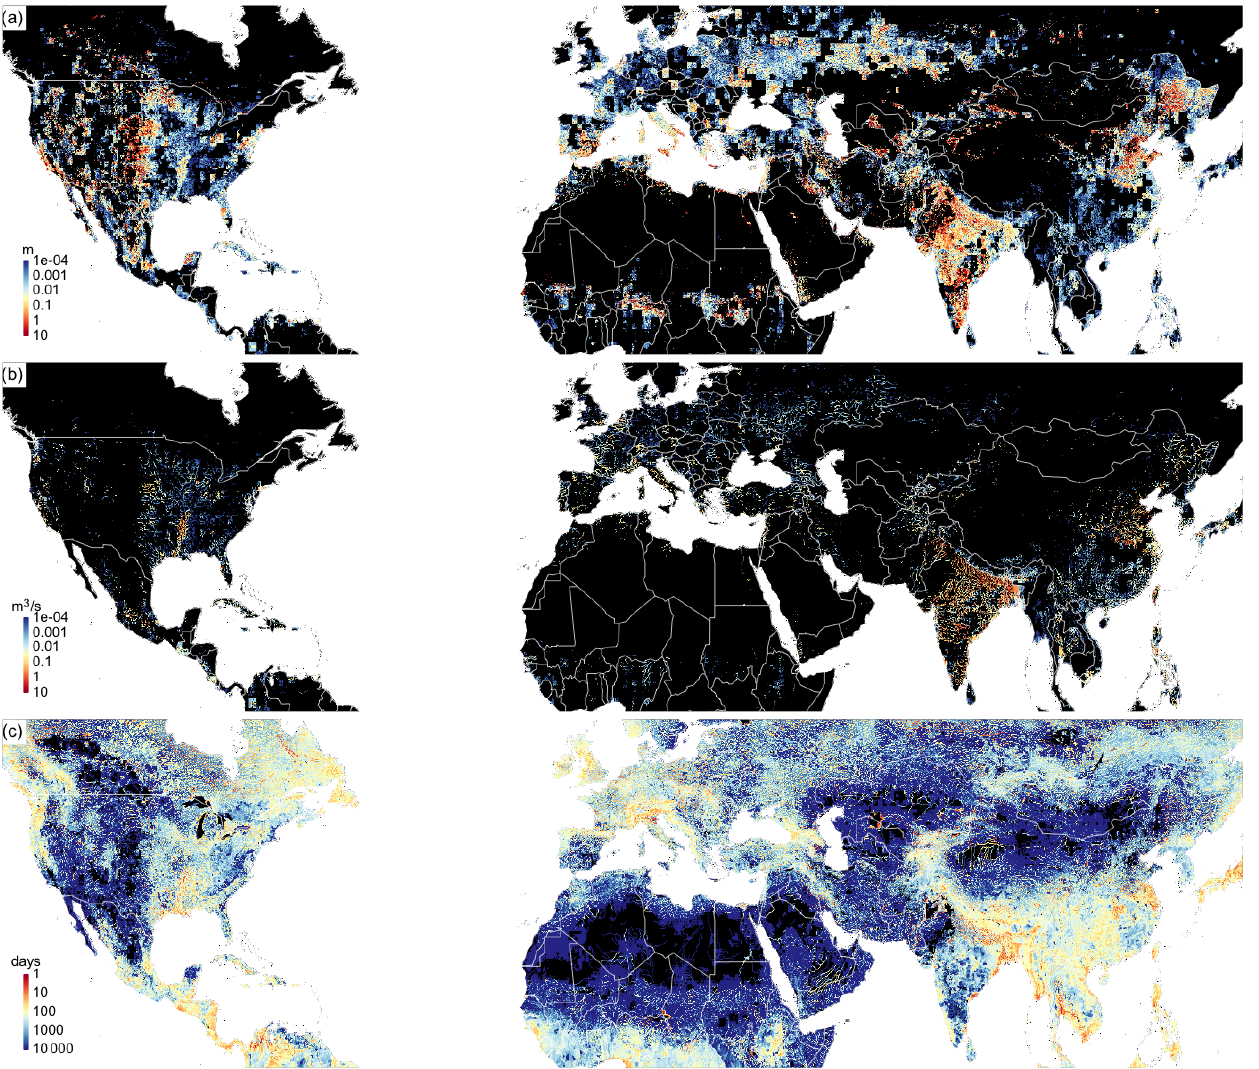
Figure 6. Results for the areas with stable withdrawal rates (q ≤ q crit ) ; (a) equilibrium groundwater-level decline (m); (b) equilibrium reduction of discharge (m 3 s − 1 ); (c) e -folding time to complete capture; black areas are areas without groundwater withdrawal, with unstable groundwater withdrawal or negligible values ( < 10 − 4